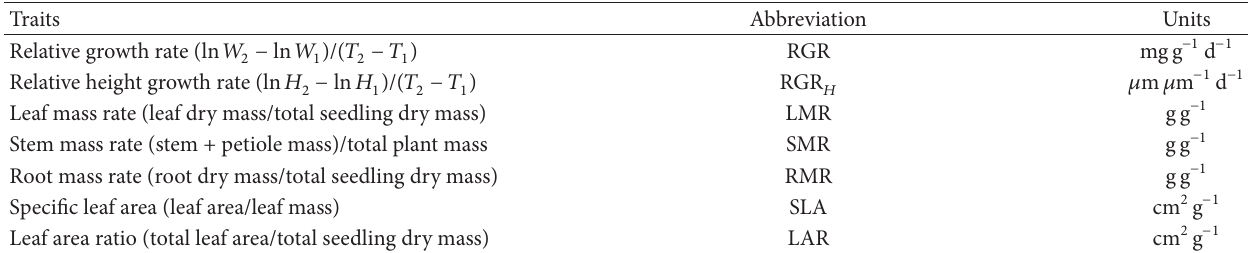
Table 1: Seedling traits, abbreviations, and units for growth and morphological analysis. These parameters were calculated following Poorter [42] and Bloor and Grubb [43].